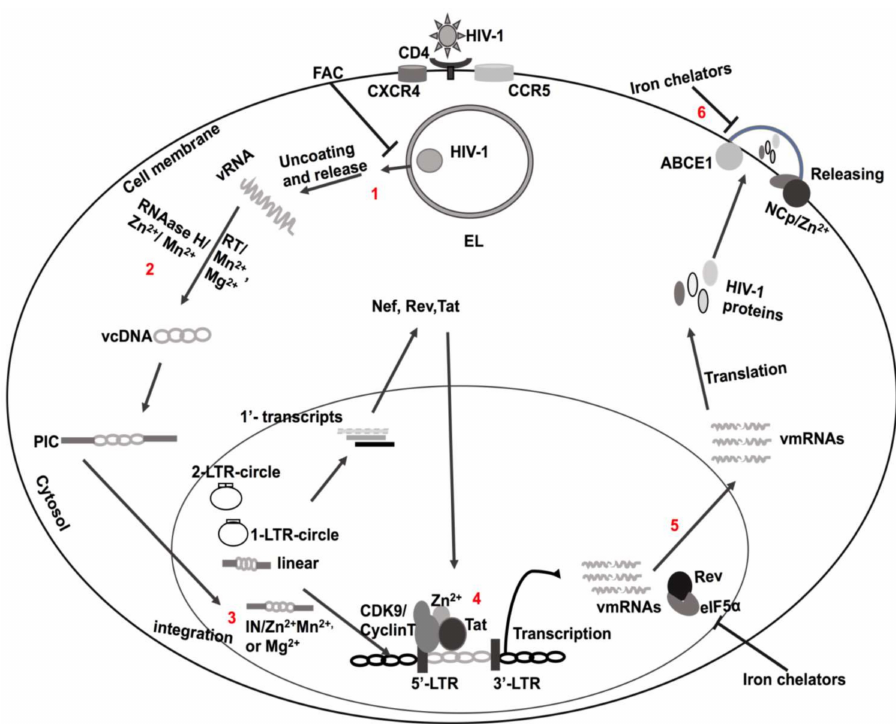
Figure 1. Roles of divalent cations in the HIV-1 life cycle and pathogenicity: 1. HIV-1 infects cells by first binding gp120 with CD4 receptors and CXCR4 / CCR5 co-receptors. Post endocytosis, HIV-1